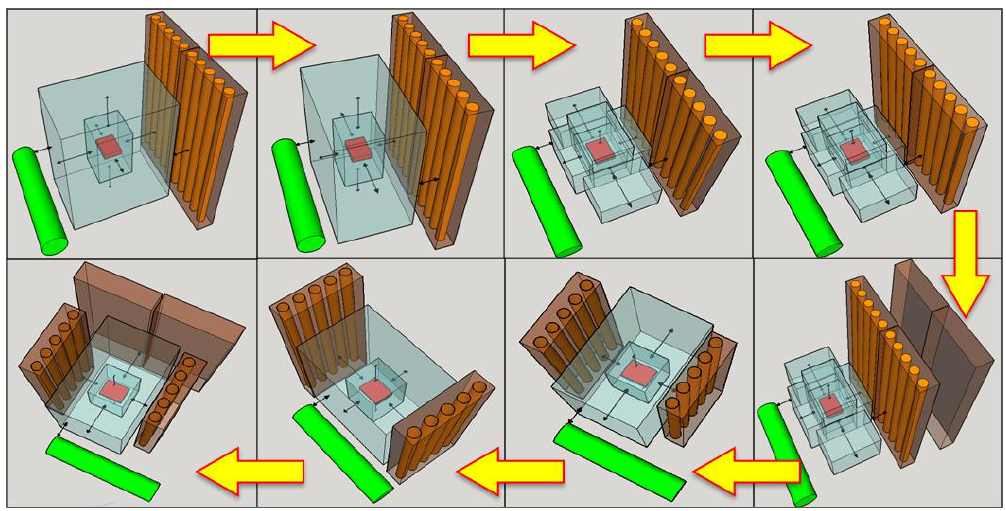
Figure 2. Example of sequential trials in the optimization process to get the best measurement configuration for small volume samples. In green the neutron generator, in transparent blue the moderating structure around the sample to be measured (red), in orange the 3 He tubes embedded into a polyethylene structure (in gray).